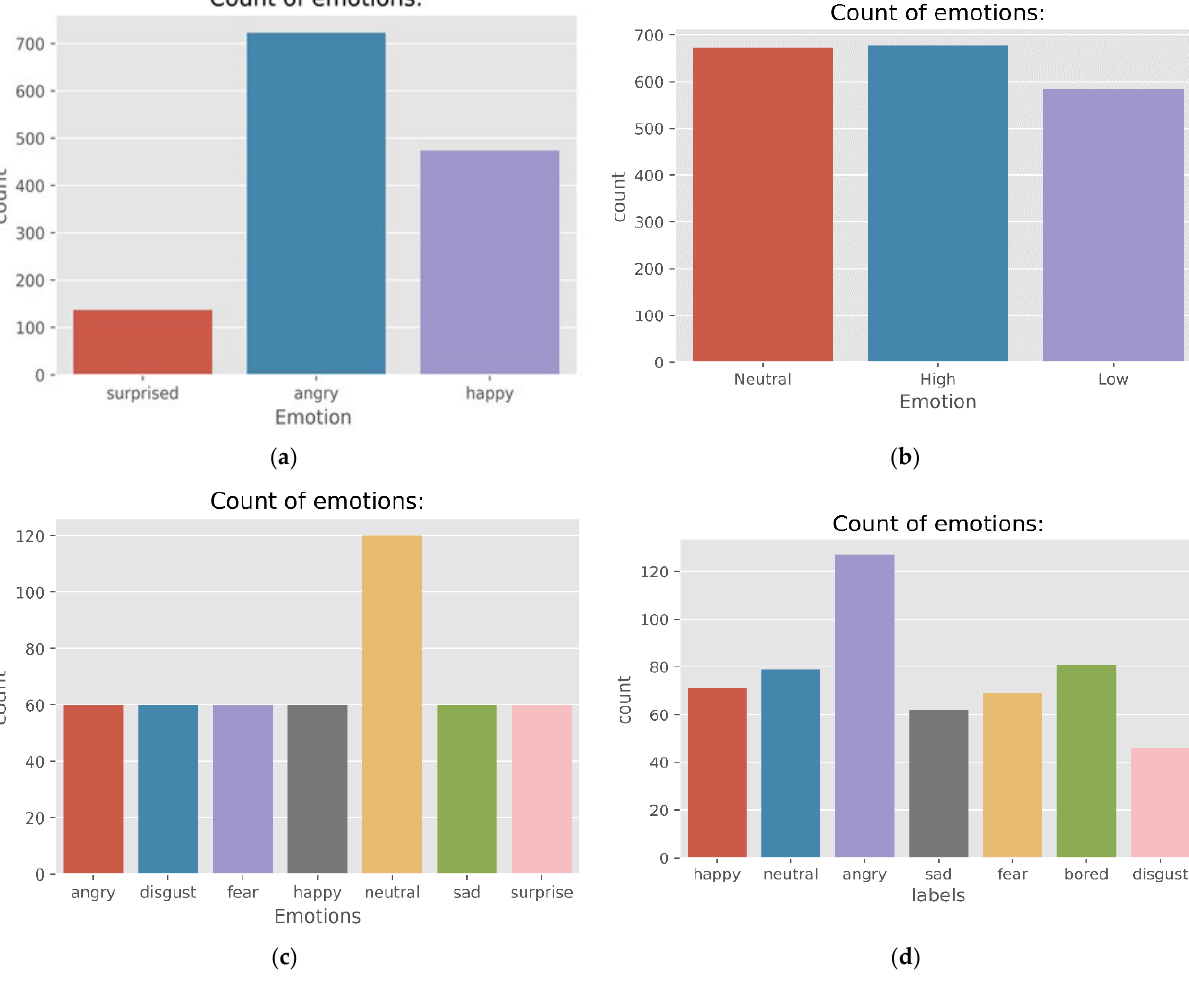
Figure 2. Distribution of emotions in the ( a ) ANAD, ( b ) BAVED, ( c ) SAVEE, and ( d ) EMO-DB da-